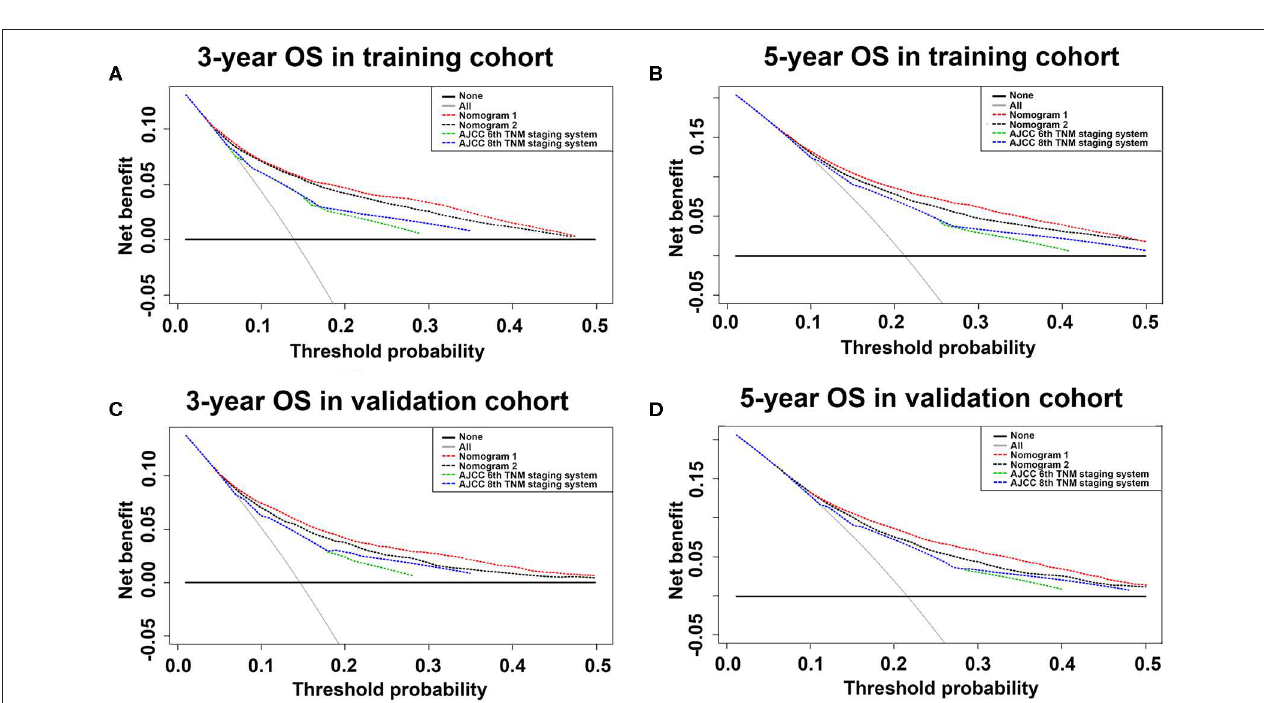
FIGURE 6 | Decision curve analysis of training and validation cohorts for three- and five-year OS. Decision curve analysis was used to compare clinical net benefits between nomograms and conventional staging systems in terms of three-year OS for (A) training and (C) validation cohorts and five-year OS for (B) training and (D) validation cohorts. For decision curve analysis, horizontal solid black line assumed no patients would die and dotted gray line assumed all patients would die.